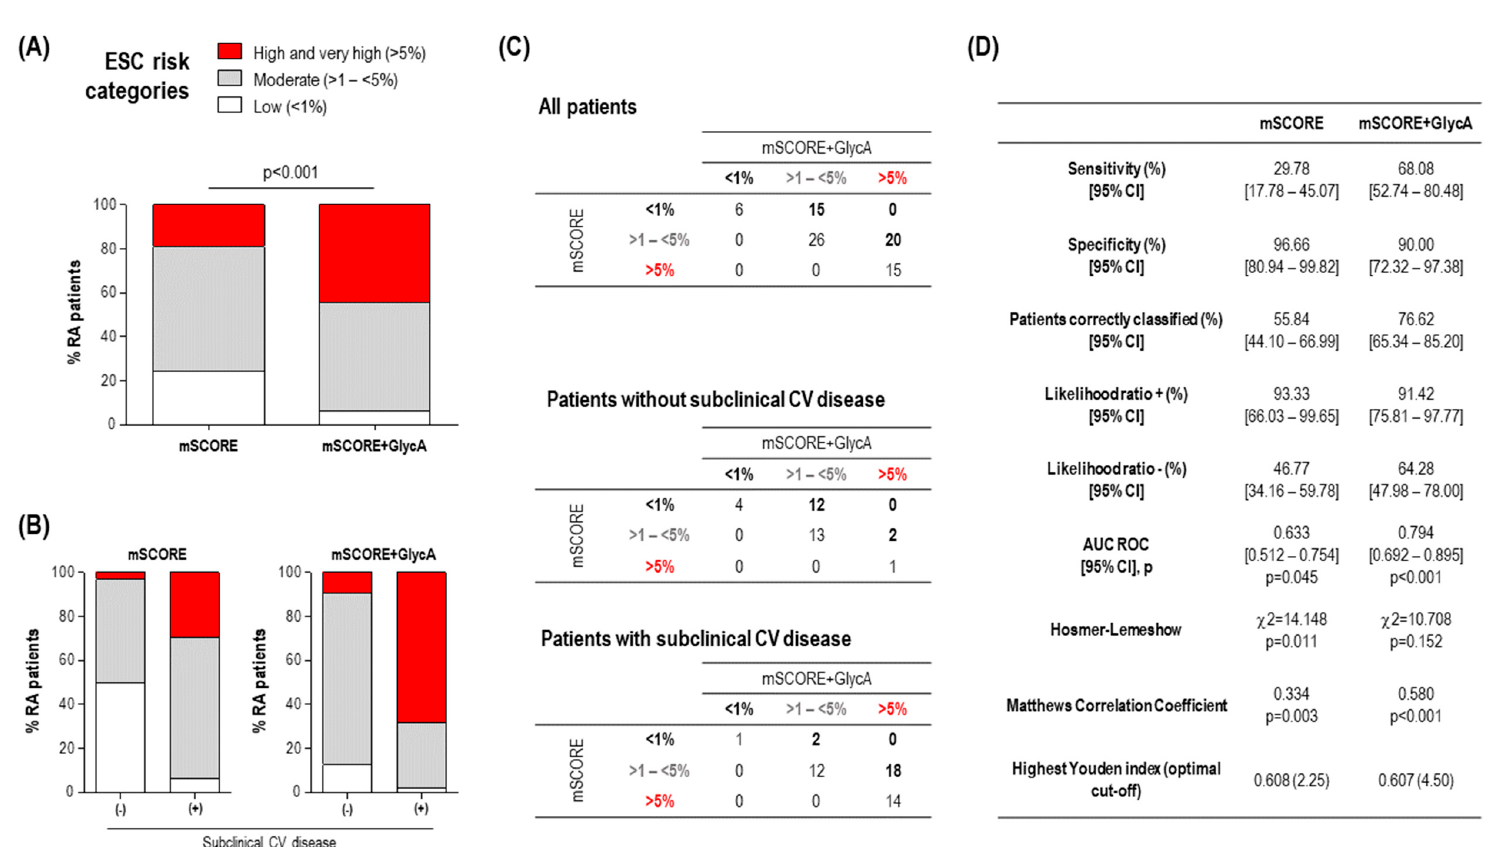
Figure 2. GlycA improved CV risk stratification in early RA. ( A ) Adding GlycA to the mSCORE increased the proportion of early RA patients reaching the high and very high risk categories. Differences between groups were assessed by 2 test. ( B ) Adding GlycA to the mSCORE was shown to reclassify a considerable proportion of patients into a more appropriate CV risk group according to their subclinical CV disease status, compared with mSCORE alone. ( C ) Comparative analyses of the stratification based on risk groups of the mSCORE and mSCORE + GlycA. Numbers in the tables indicate the number of individuals according to each mSCORE/mSCORE + GlycA status. Numbers below or above the diagonal correspond to reclassified patients (highlighted in bold). ( D ) Comparative classification and calibration metrics for mSCORE and mSCORE + GlycA for the identification of patients with subclinical CV disease. Analyses were made according to the statistics presented in the first column. AUC ROC, area under the receiver operating characteristic curve.